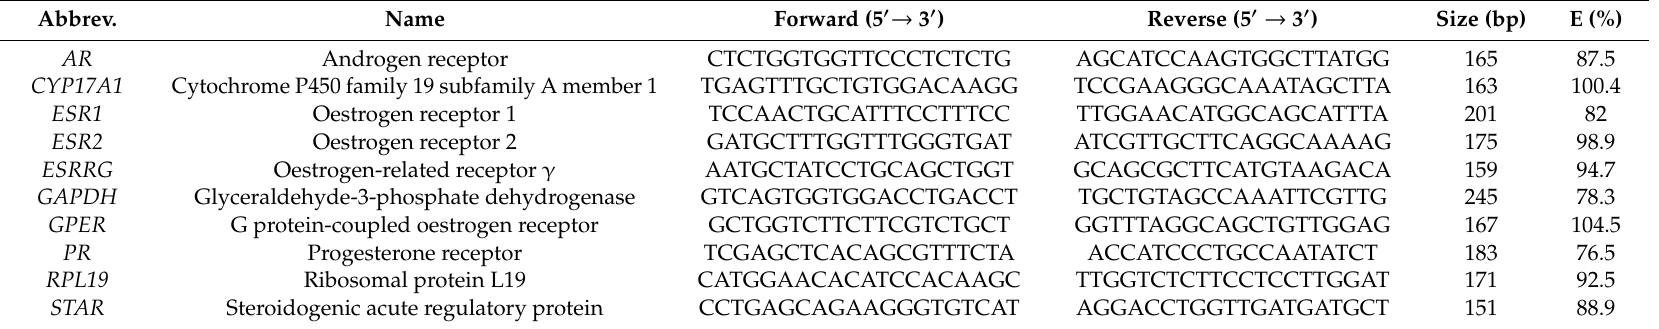
Table 1. Oligonucleotide primer